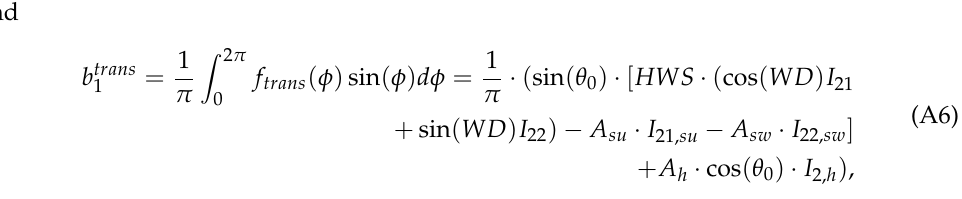
integrals of Table A1. As mentioned, the mnemonic subscript m = 1 ( m = 2 ) refers to the Fourier coefficient a 1 ( b 1 ) . The subscripts su , sw , and h denote the “surge”, “sway”, and “heave”, respectively.